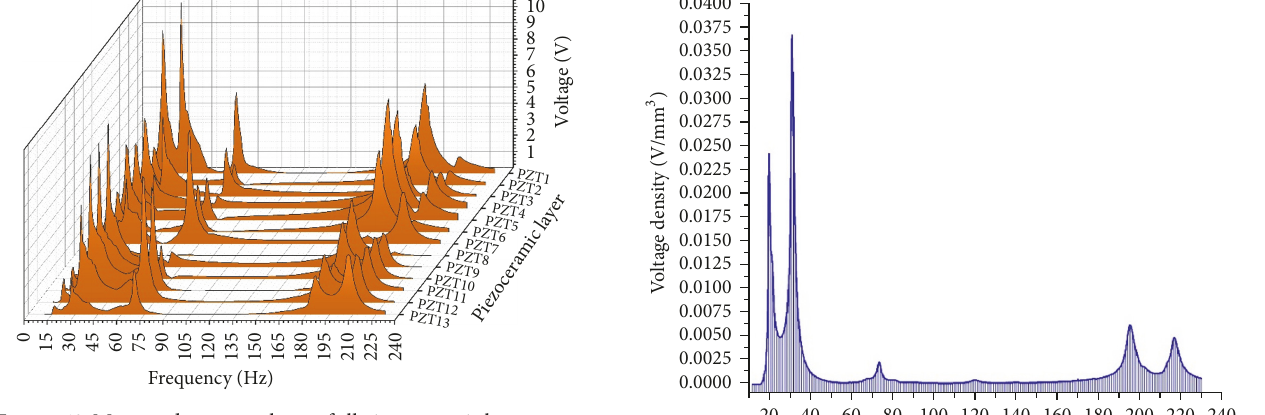
Figure 13: Measured output voltage of all piezoceramic layers versus frequency.